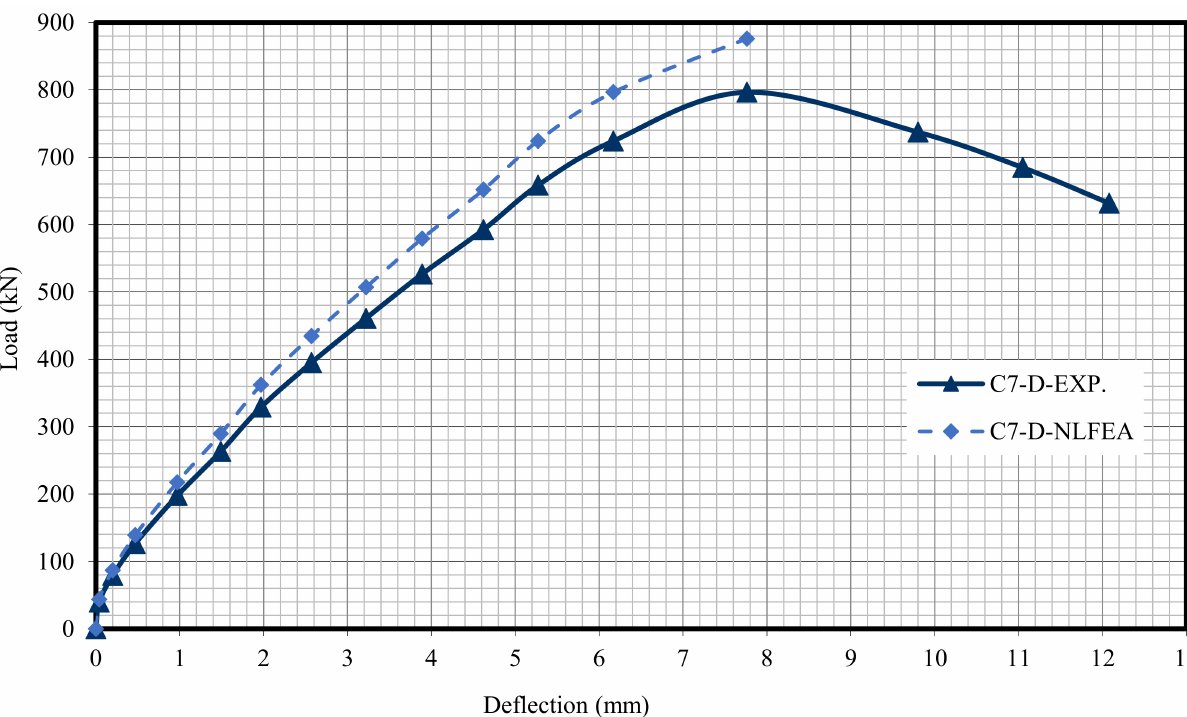
Figure 28. Load deflection of Column